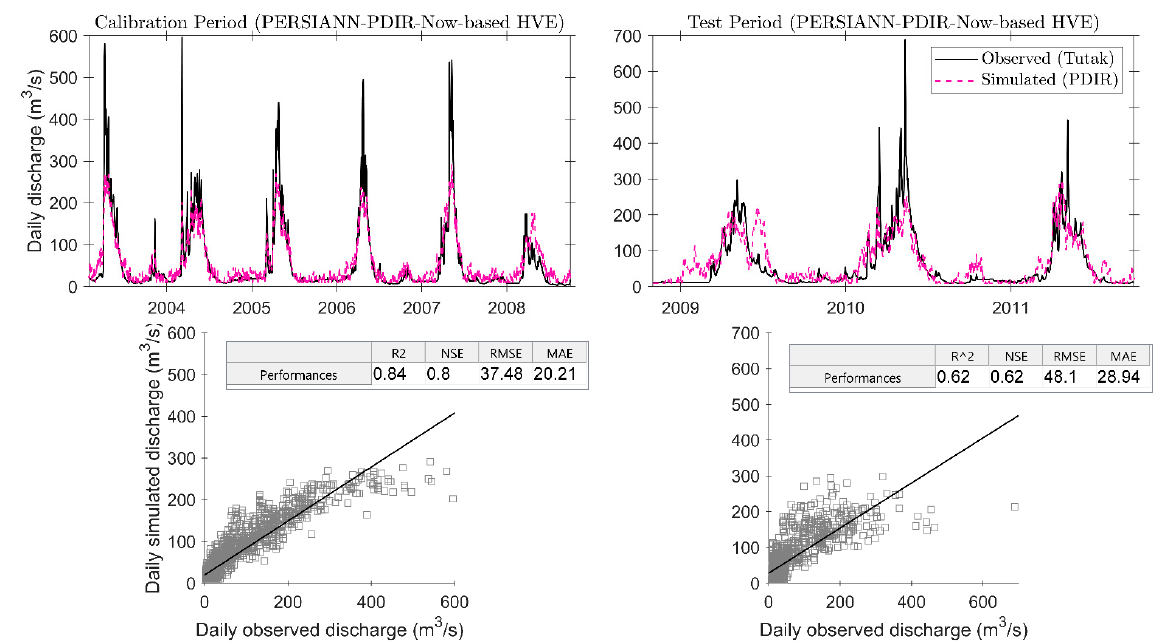
Figure 13. HVE results using PERSIANN-PDIR SBP data.